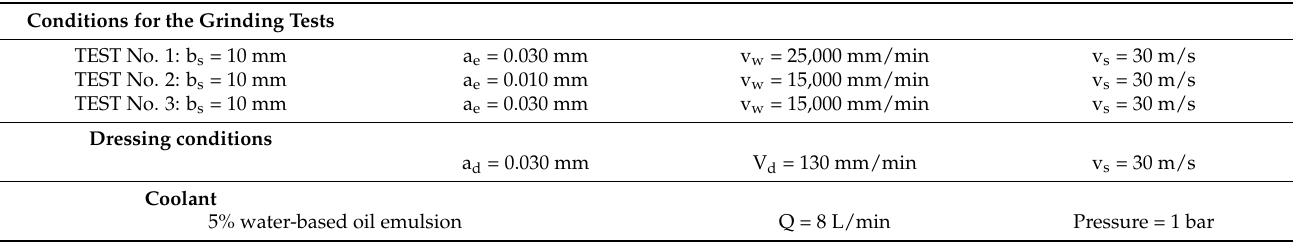
Table 1. Definition of the exerimental